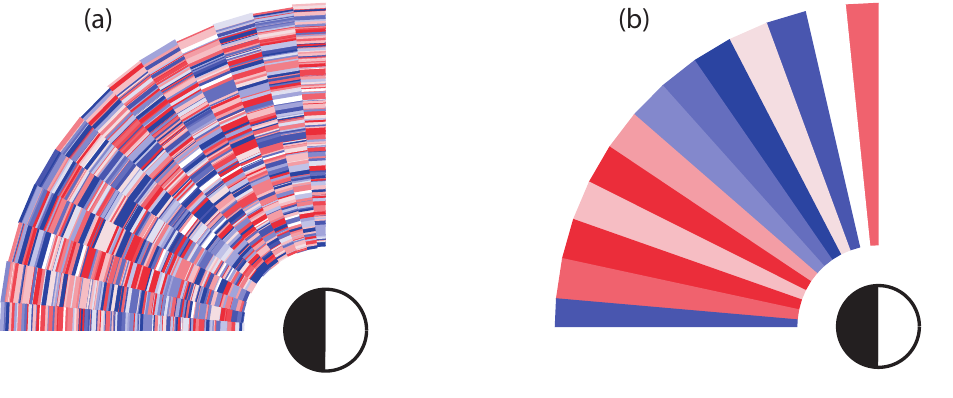
Fig. 3. A schematic illustration of two extreme limits of radial distribution of the electric field structures in stormtime Pc5s: (a) δL rms → 0 and (b) δL rms → L 0